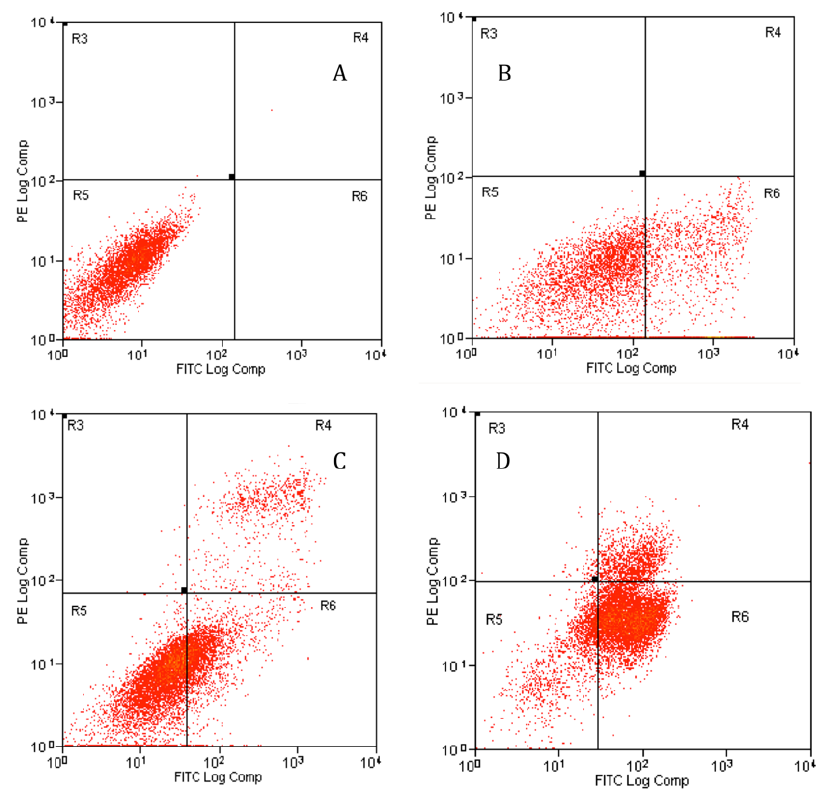
Figure 5. Annexin V-FITC analysis of PC-3 cells treated with GMG-ITC (3.5 µg/mL) for 24 ( B ), 48 ( C ), and 72 ( D ) hours, with ( A ) representing the untreated cells. Early apoptosis (Annexin+/PI − ) is shown in the lower right quadrant (Q4) for each panel while late apoptosis (Annexin+/PI+) is shown in the upper right quadrant (Q2). Viable cells are represented in the lower left quadrant (Q3). Necrosis (Annexin−/PI+) is shown in the upper left quadrant (Q1). Results represent one of three independent experiments.